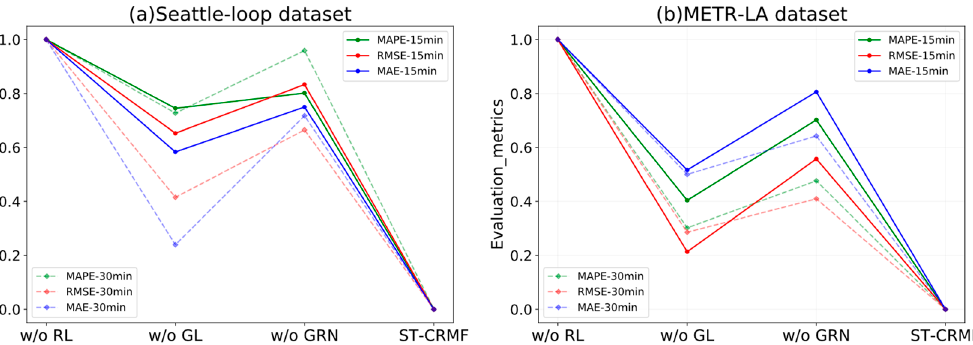
Figure 9. Ablation experiments of the ST-CRMF model on the Seattle-Loop and METR-LA da-